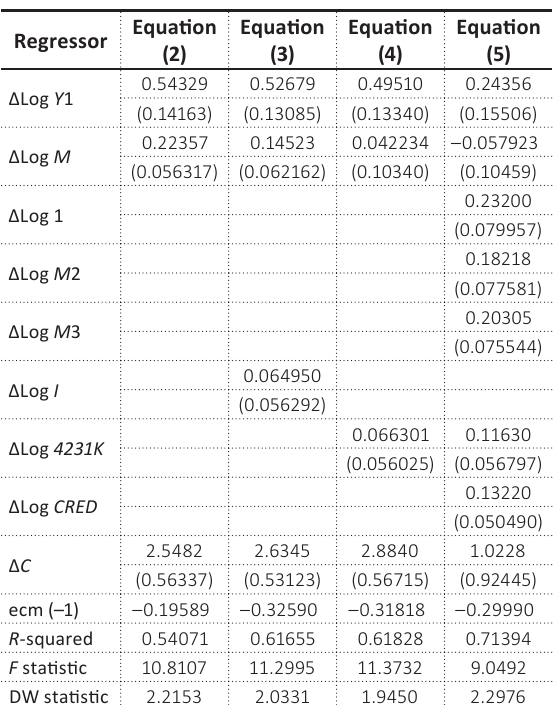
Table 5. Estimated long-run coefficients using the ARDL Approach-Dependent variable